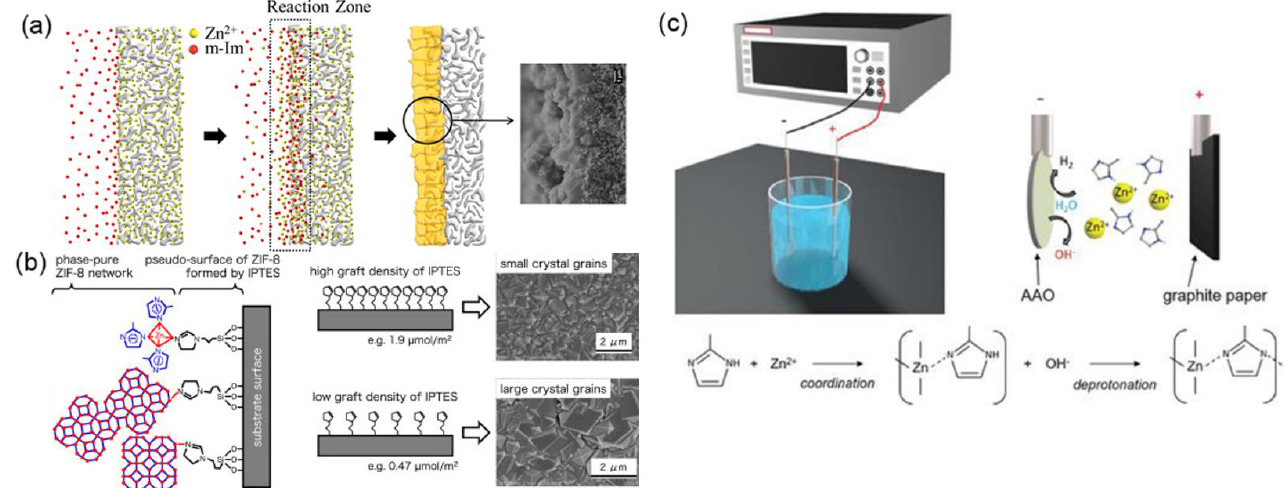
Figure 6. ( a ) Schematic illustration of membrane synthesis using the counter-diffusion method [17]. ( b ) Schematic image of the heterogeneous nucleation and crystal growth on the 3-(2-imidazolin-1-yl)propyltriethoxysilane (IPTES)-modified surface [73]. ( c ) Illustration of the experimental apparatus of atomic layer deposition (ALD) for the fabrication of ZIF-8 membranes